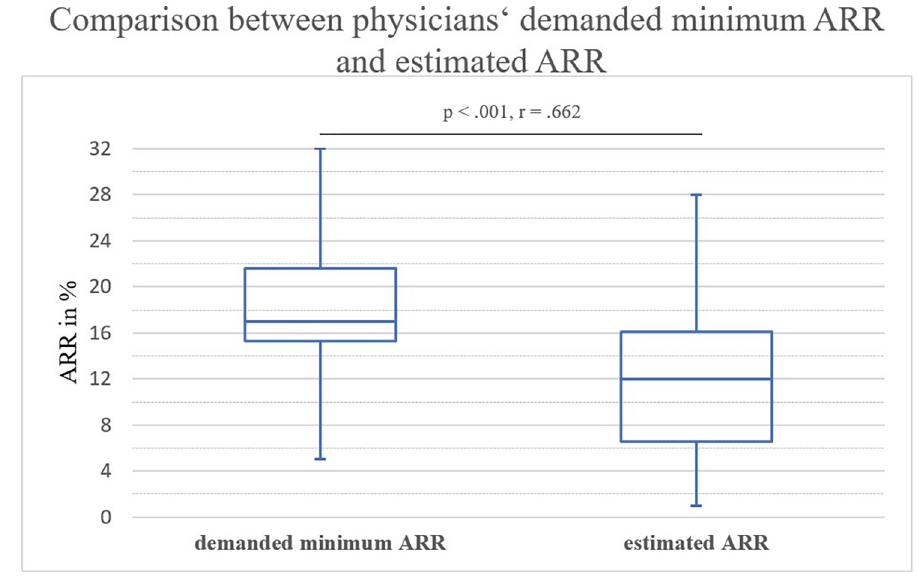
Fig 4. Box plot comparison of demanded minimum ARR and estimated ARR of bisphosphonates of physicians. Median, Q1 and Q3 are reported. Whiskers indicate minimum and maximum.